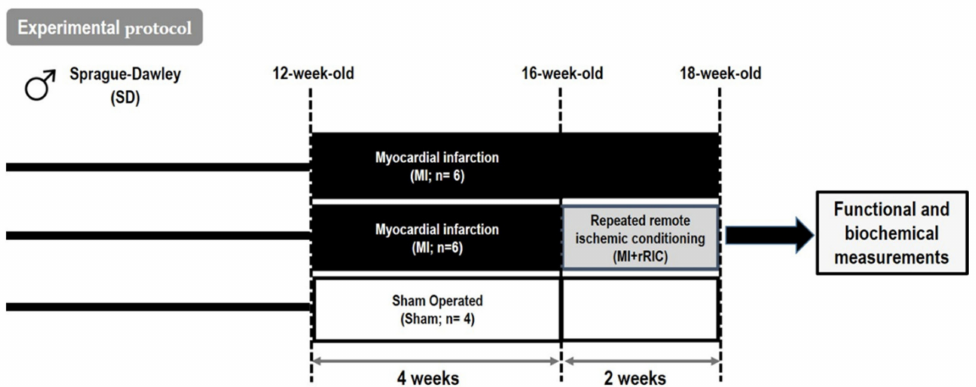
Figure 1. Scheme of the experimental protocol. The left anterior descending coronary artery (LAD) was ligated to induce myocardial infarction (MI group, n = 6) in 12-week-old male rats. rRIC was performed by 3 cycles of 5-min-long unilateral hind limb ischemia and 5 min of reperfusion once a day for 2 weeks, 4 weeks after LAD ligation in a separate group of animals (MI + rRIC group; n = 6). Sham operated animals (Sham group, n = 4) served as controls. Myocardial tissues were collected at 18 weeks for functional and biochemical measurements.